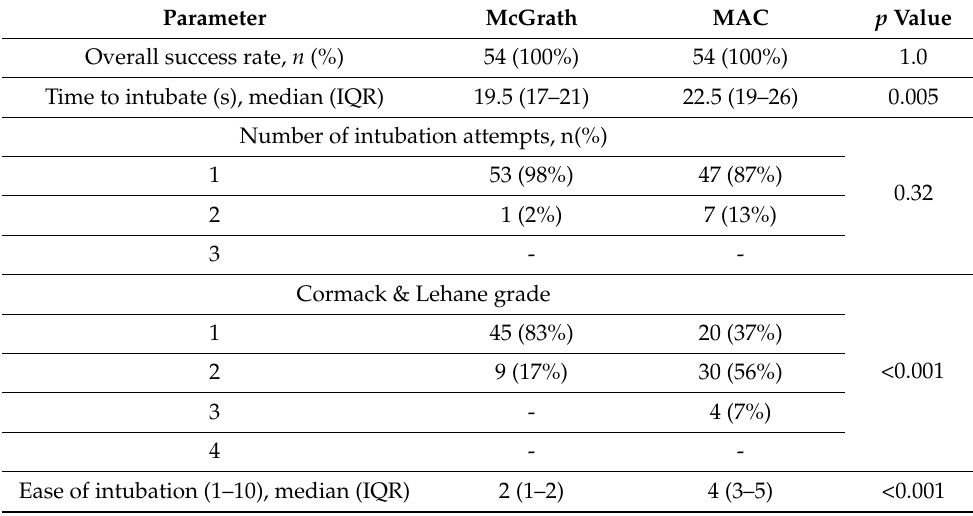
Table 1. Intubation with McGrath and Macintosh laryngoscopes without personal protective equipment-aerosol-generating procedure (PPE-AGP)